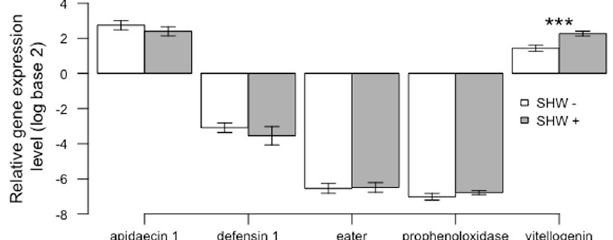
Figure 6. Gene expression levels according to the SHW treatments. Mean and standard error of relative gene expression levels of apidaecin 1, defensin 1, eater, prophenoloxidase and vitellogenin in bees sampled at the end of an SHW − (white bars) or SHW + period (grey bars) (n = 27 pool of bees per treatment). Significant differences between groups are indicated ( *** P < 0.001, ANOVA).